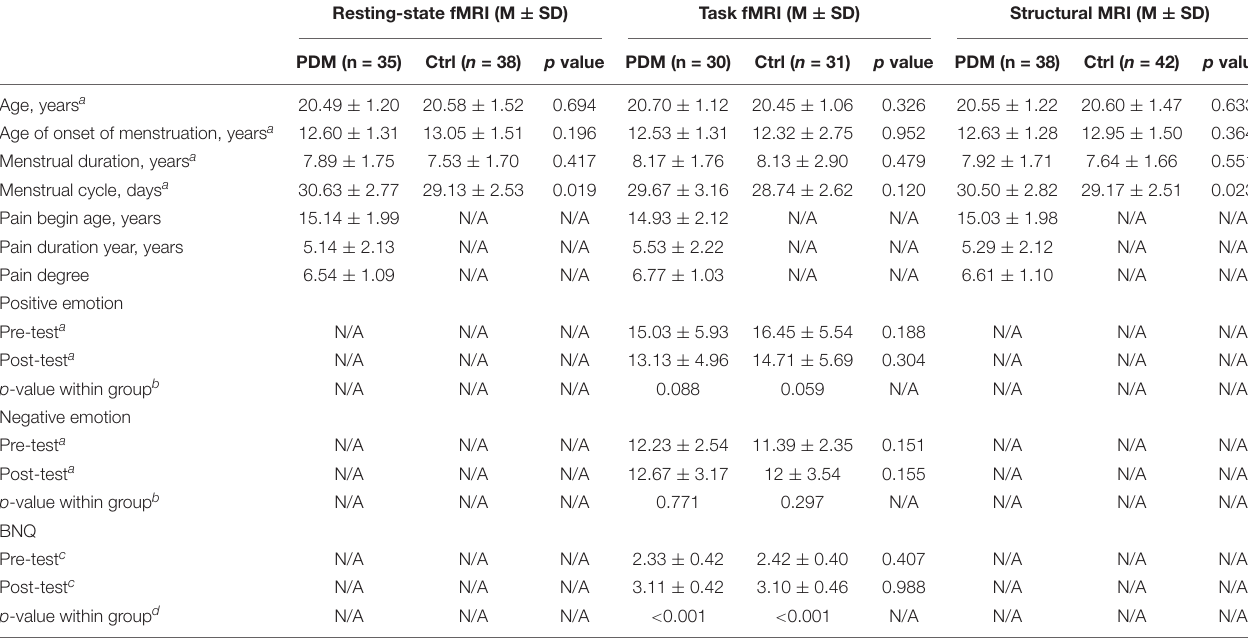
TABLE 1 | Demographic and clinical information of the PDM subjects and controls used in human